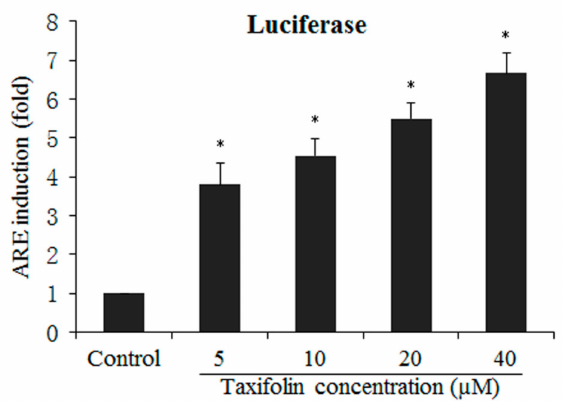
Figure 4. Induction of antioxidant response element (ARE)-luciferase activity by TAX treatment at concentrations from 5 to 40 µ M in HepG2-C8 cells expressed with ARE-luciferase vector. The cells were treated with TAX 5 to 40 µ M for 24 h. The normalization of the luciferase activity was performed on the basis of protein concentrations. The data were obtained from three independent experiments and expressed as the inducible fold change relative to that of the vehicle control. * p < 0.01, indicating significant differences between the treatment and control